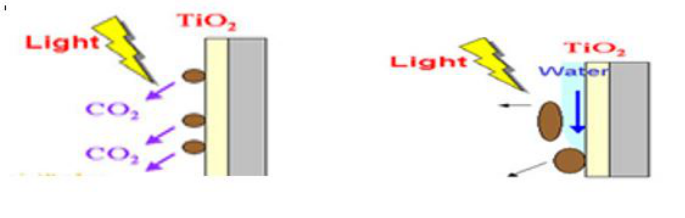
Figure 5. the application of self-cleaning of glass (Leydecker,